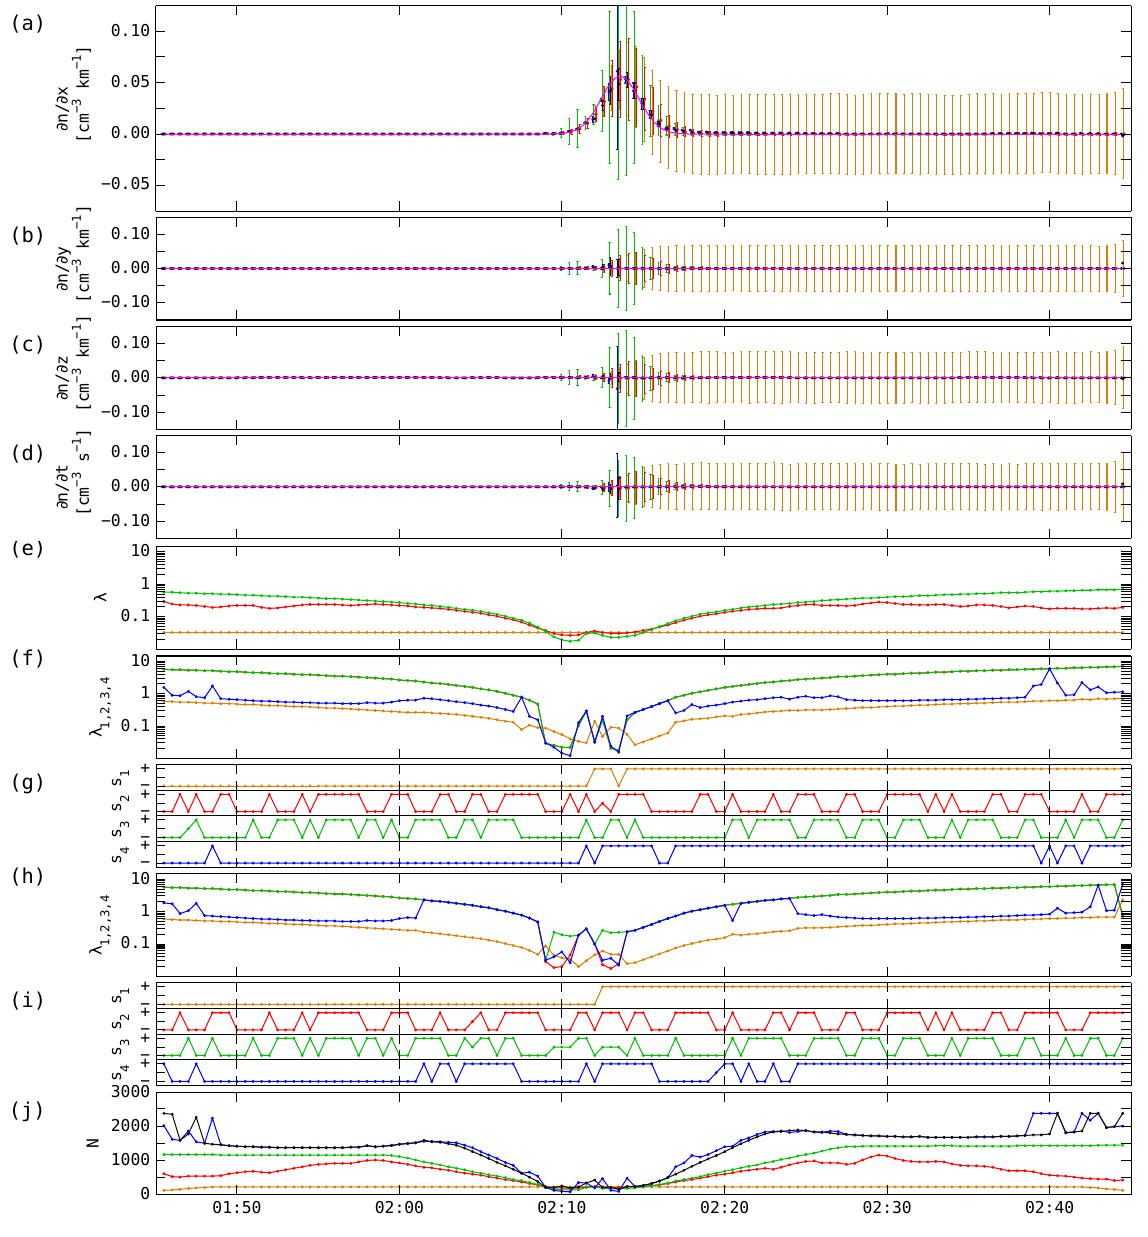
Fig. 10. Least-squares gradient at a density interface (10 spacecraft, medium separation, 5% measurement error, smoothed at a 30s time scale, resampled at 15s resolution). See caption of Fig. 6.